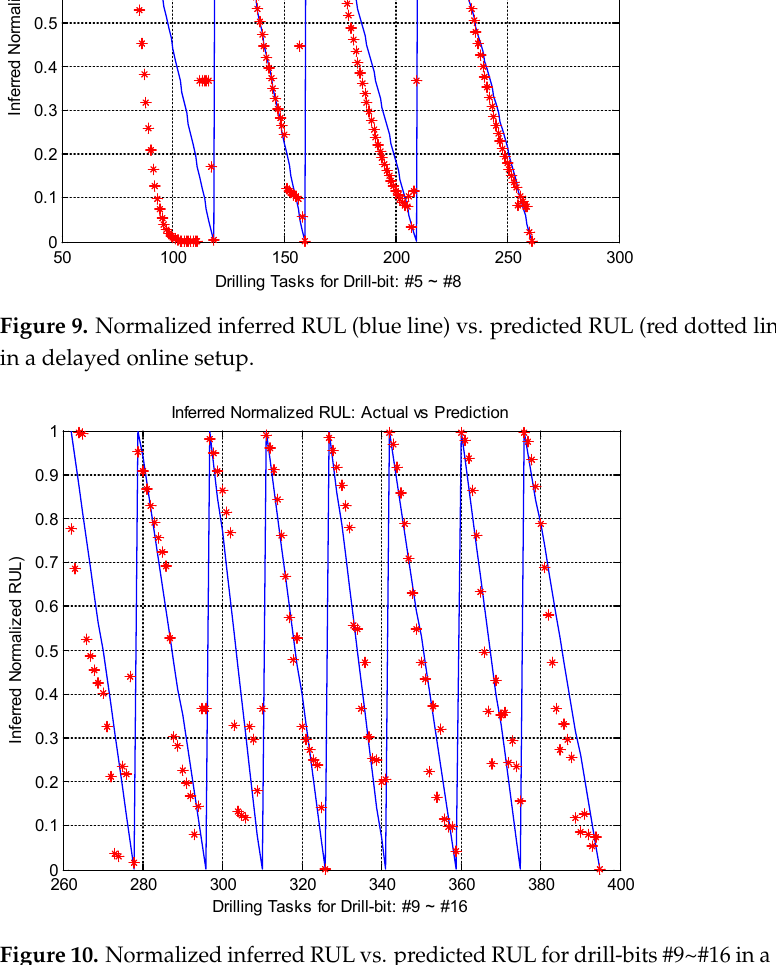
Figure 10. Normalized inferred RUL vs. predicted RUL for drill-bits #9~#16 in a delayed online setup.